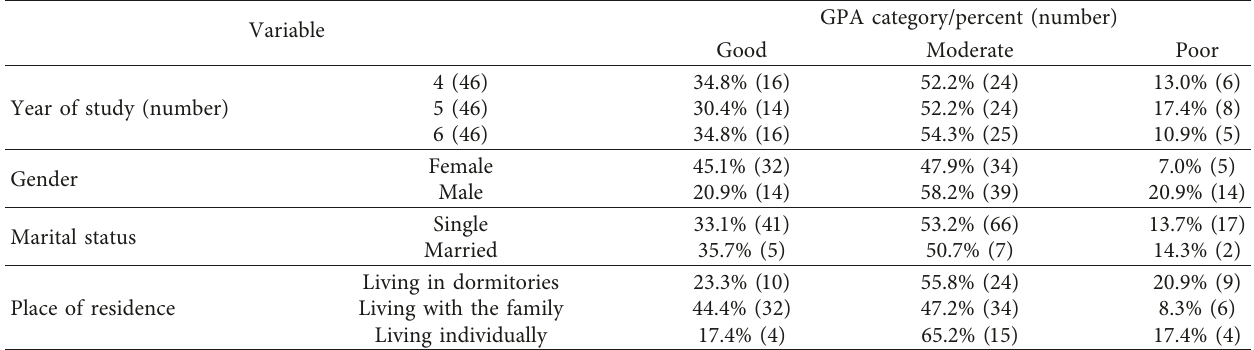
Table 3: GPA scores of the participants based on year of study, gender, marital status, and place of residence.